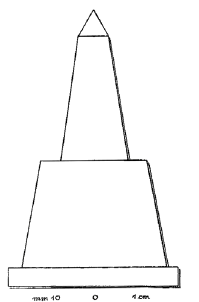
Figure 2: the determinative found in the contemporary tomb of the fifth dynasty priest Ty at